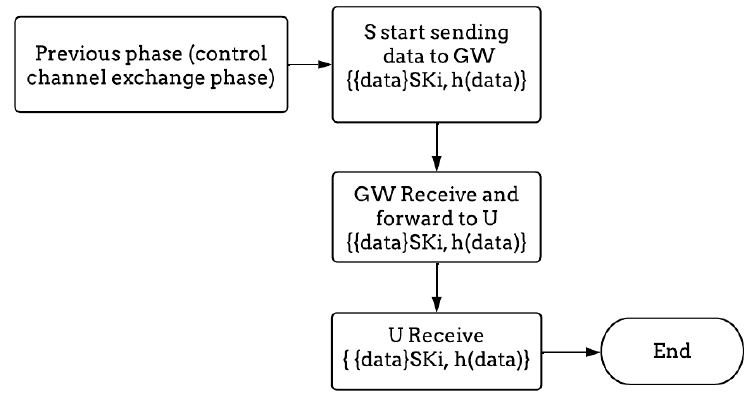
Figure 7. The flow diagram of the data exchange phase.